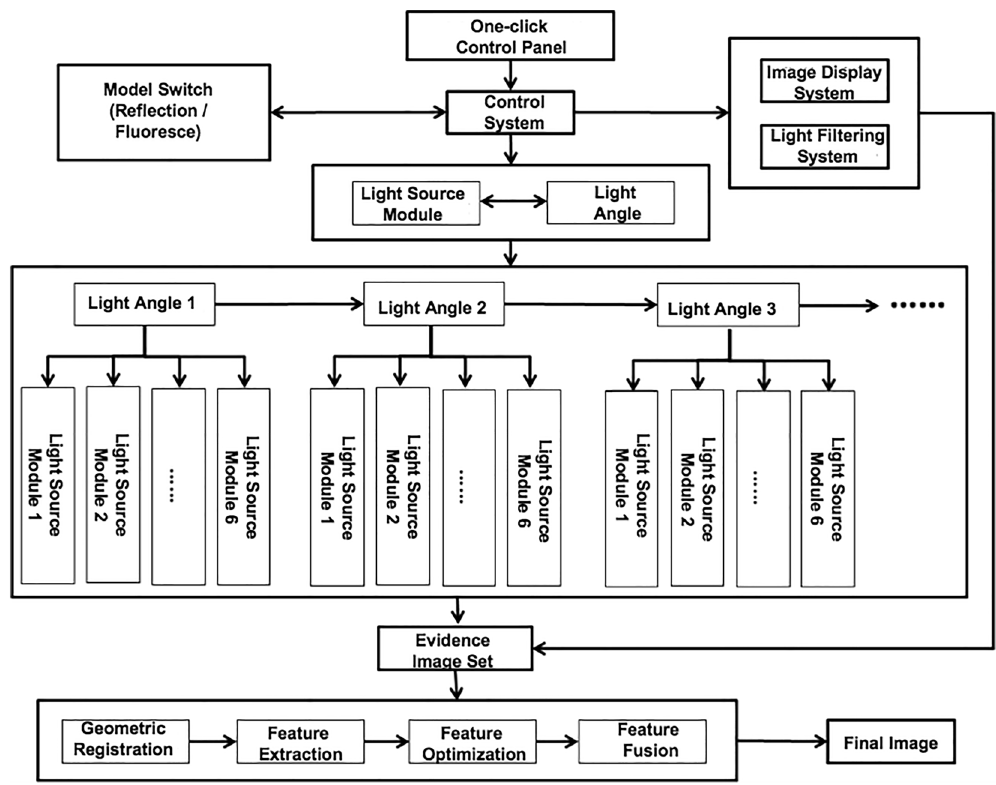
Figure 4. Functional design of the one-click control